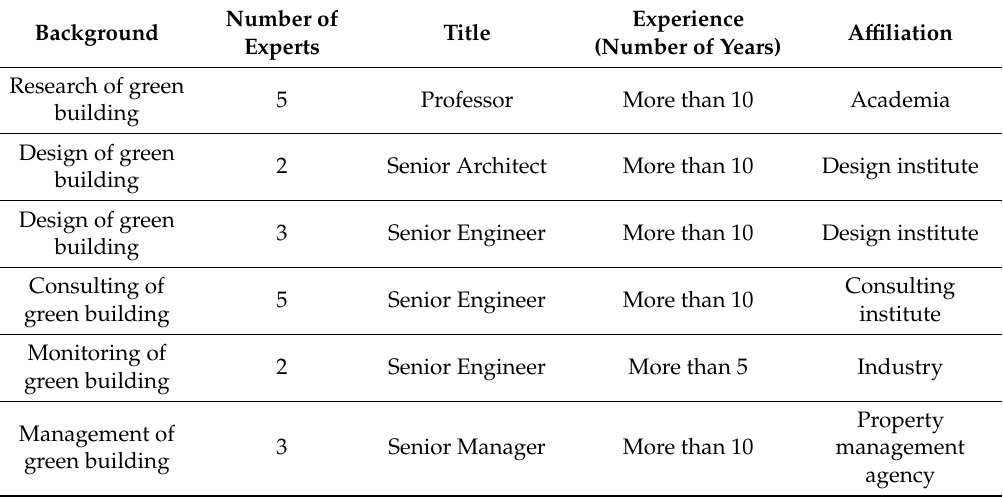
Table 3. Experts and their